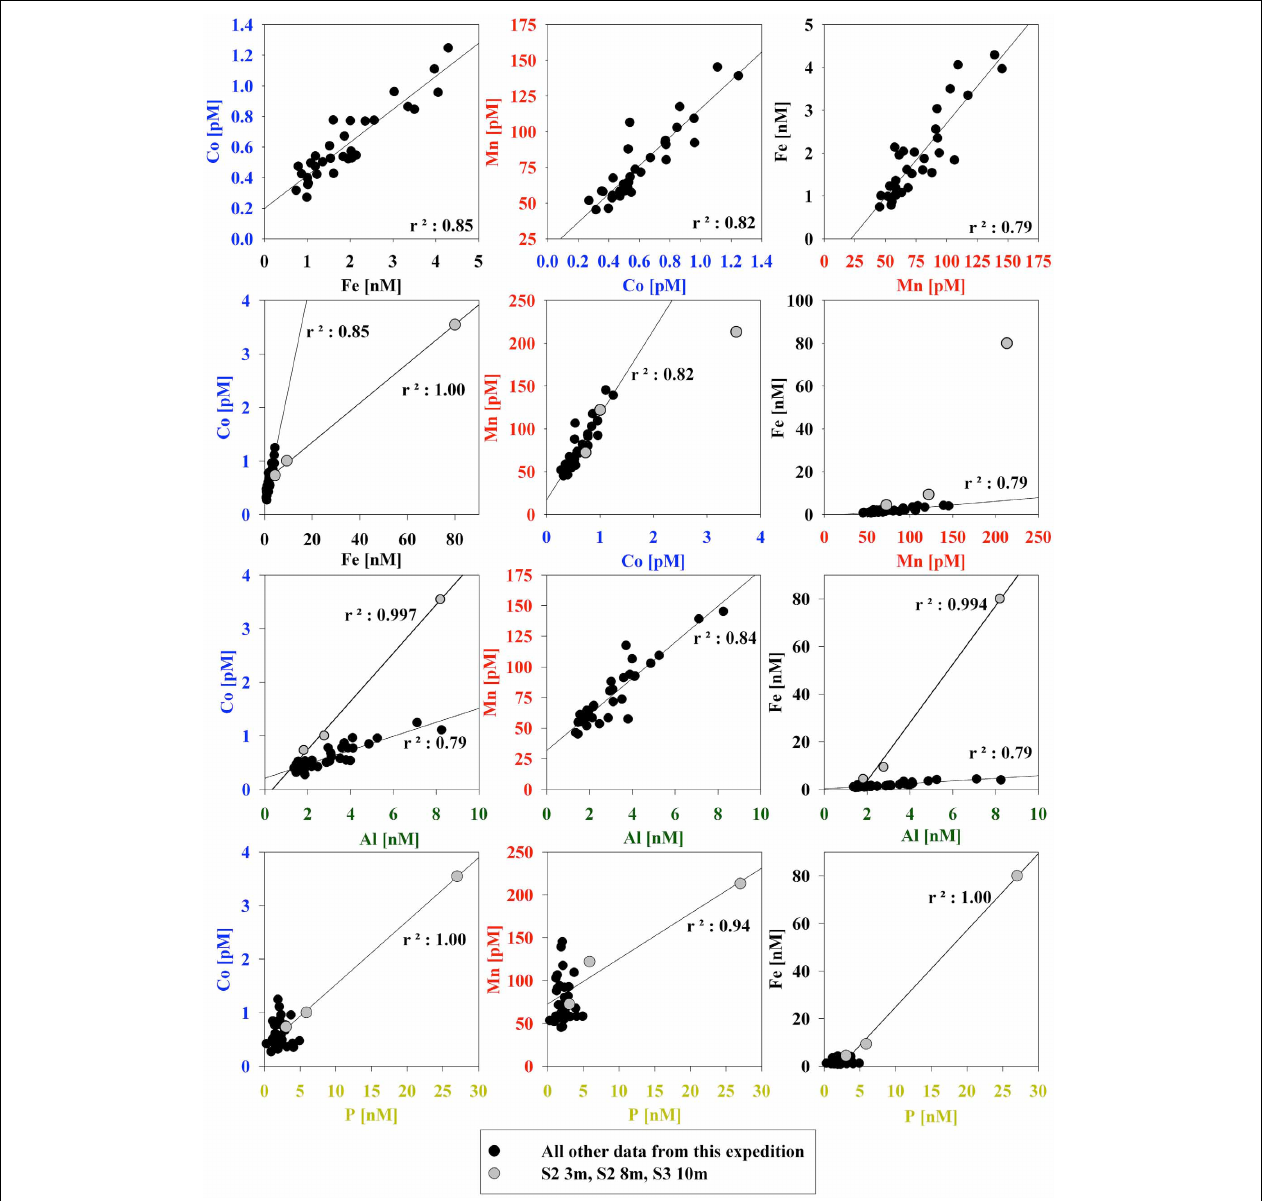
FIGURE 4 | Correlations between particulate bioactive trace metals for all three stations sampled. Surface samples where biological activity was evidently high are shown in red (Station 2 = 3m, Station 2 = 8m, Station 3 =